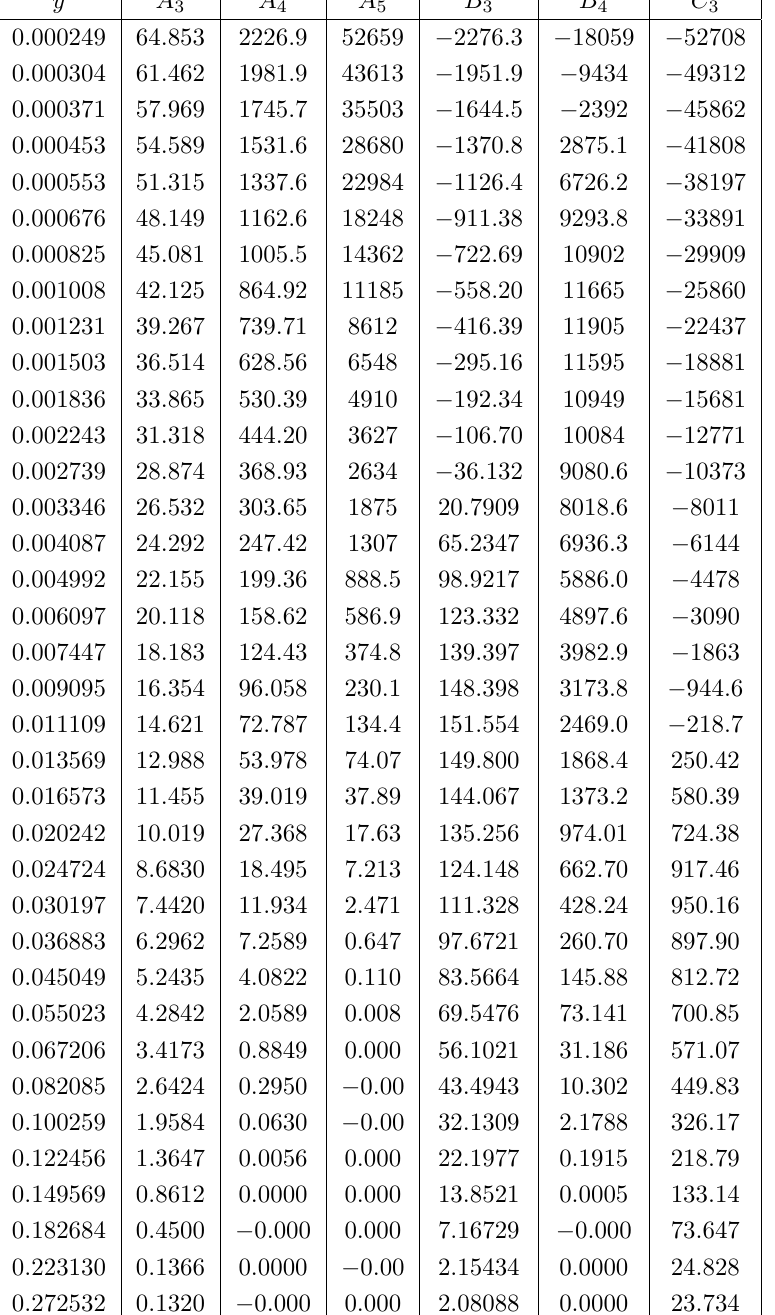
Table 3 . The perturbative coe(cid:14)cients entering eq. (2.5) as calculated by the MCCSM